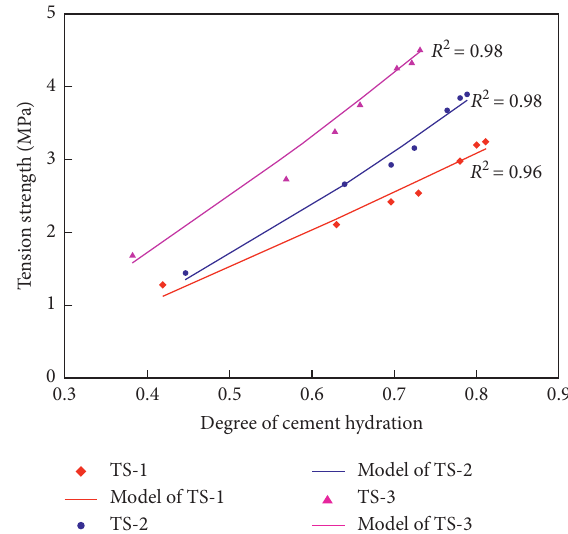
Figure 5: Test and fitting values of concrete tensile strength and hydration degree of TS-1 concrete, TS-2 concrete, and TS-3 concrete.